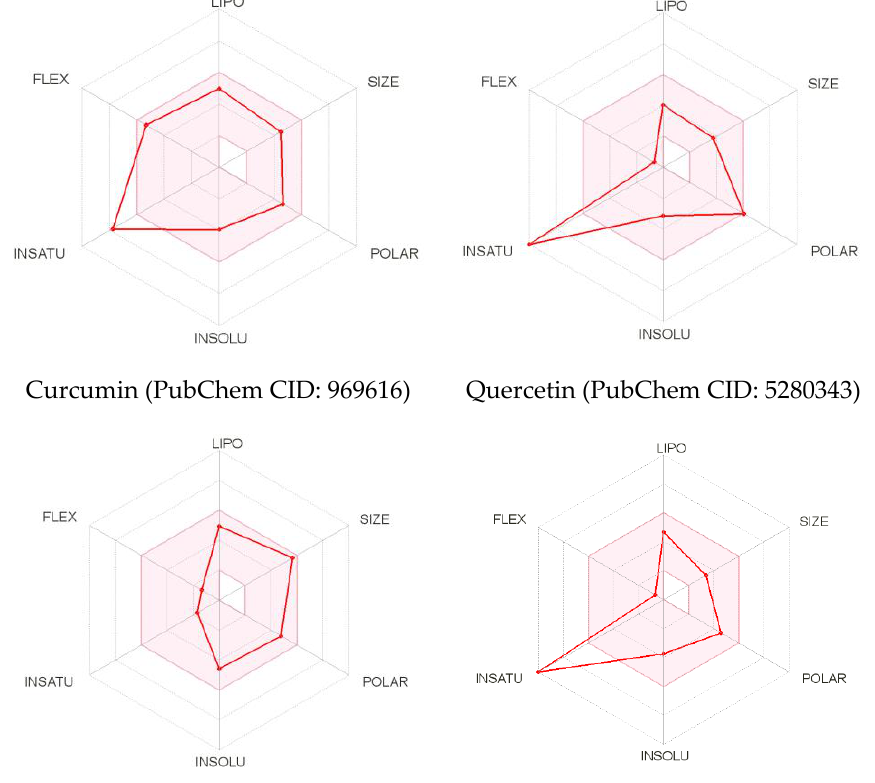
Figure 3. The physicochemical space for oral bioavailability. The bioavailability radar provides an initial assessment of drug-likeness of a molecule. The colored zone is the suitable physicochemical space for oral bioavailability. The comprehending outcomes for physicochemical space of curcumin (PubChem CID: 969616), quercetin (PubChem CID: 5280343), withanolide (PubChem CID: 53477765), and genistein (PubChem CID: 5280961) were illustrated following the parameters as of LIPO (Lipophility): − 0.7 < XLOGP3 < +5; SIZE: 150 g/mol < MW < 500 g/mol; POLAR (Polarity): 20 Å 2 < TPSA < 130 Å 2 ; INSOLU (Insolubility): 0 < Log S (ESOL) < 6; INSATU (Unsaturation): 0.25 < Fraction Csp3 < 1; and FLEX (Flexibity): 0 < Num. rotatable bonds <